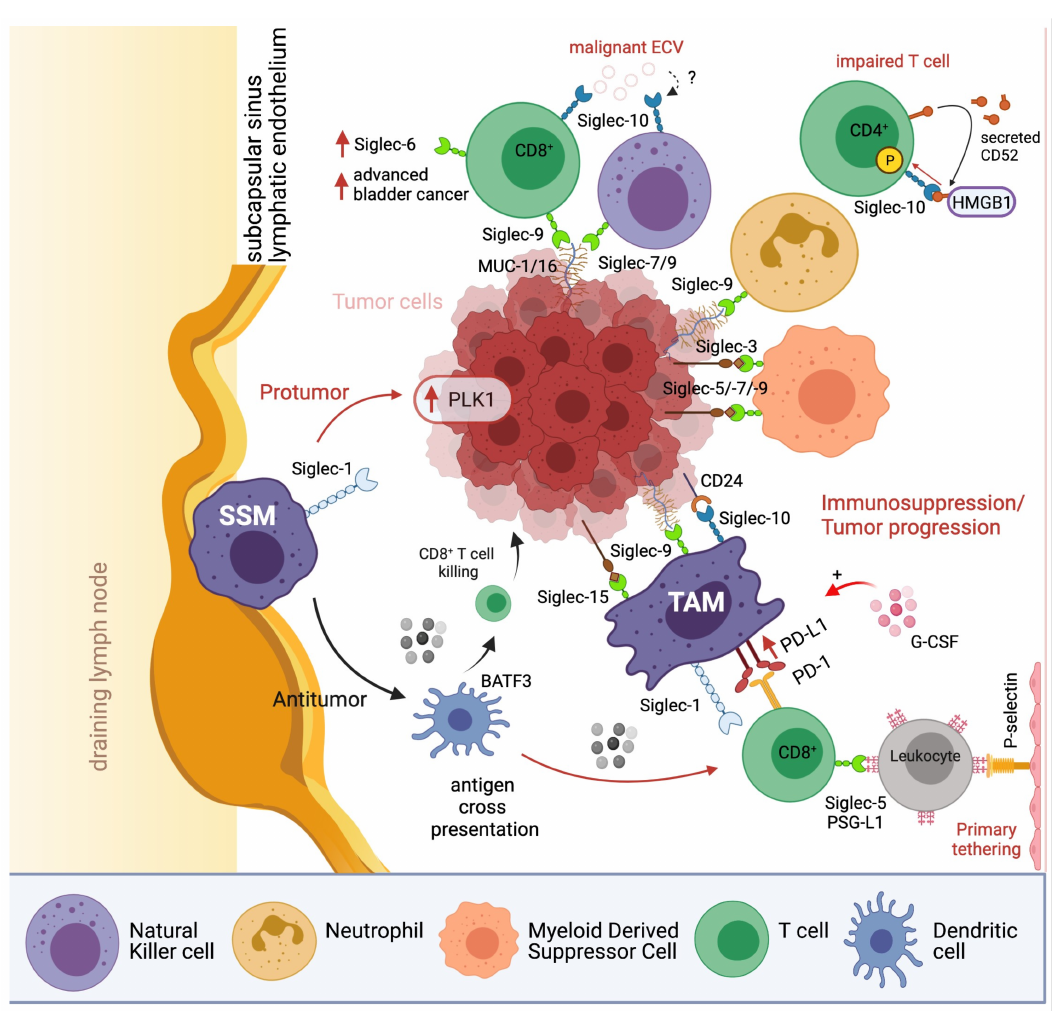
Figure 4. Overview of inhibitory mechanisms of the Siglec + immune cells in the tumor microenviroment. Protumor pathways are marked with red arrows and antitumor pathways are marked with black arrows. BATF3: Basic Leucine Zipper ATF-Like Transcription Factor 3, ECV: Extracellular vesicles, HMGB1: High-mobility group box-1, SSM: Sinusoidal macrophages, TAM: tumor-associated macrophages, PD-1: Programmed cell death protein 1, PD-L1: Programmed cell death ligand 1, PLK1: Polo-like kinase 1, PSG-L1: P-selectin glycoprotein ligand-1. SSM: subcapsular sinus macrophages. TAM: tumor-associated